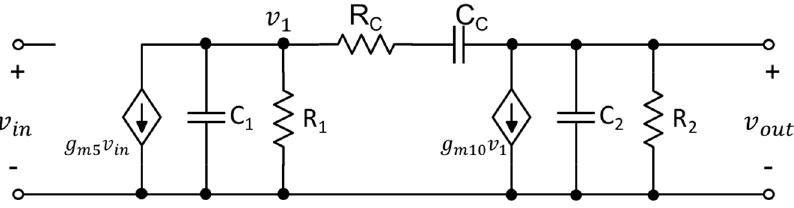
Figure 5. Small signal equivalent circuit of the two-stage opamp.